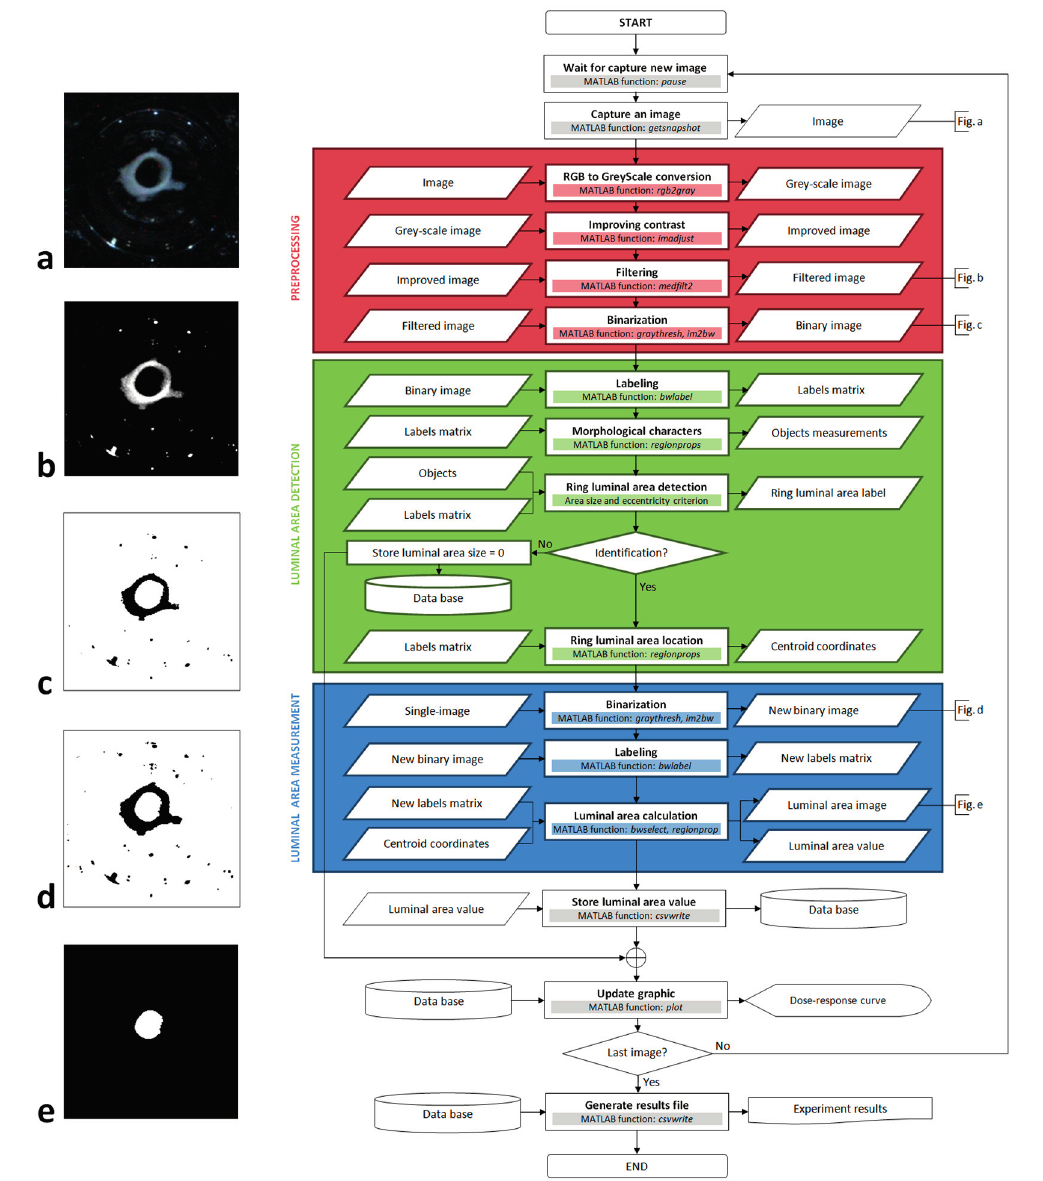
Figure 4. Image algorithm